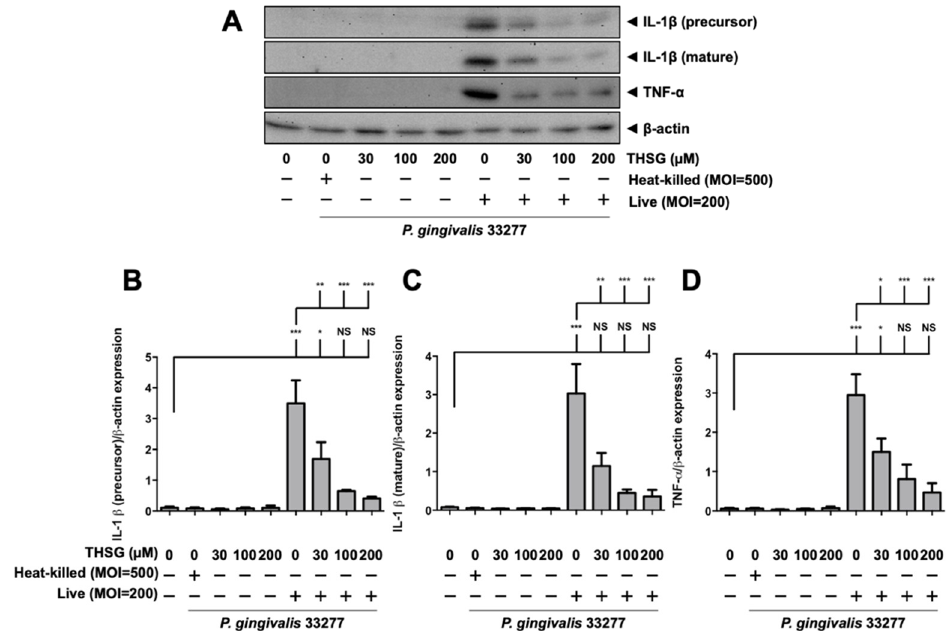
Figure 2. THSG reduces the expression of proinflammatory cytokines in P. gingivalis -infected bEnd.3 cells. ( A ) Cells were pretreated with THSG (0, 30, 100, and 200 µ M) for 2 h before being challenged with heat-inactivated (MOI 500) or live (MOI 200) P. gingivalis for 90 min. The expression of IL-1 β (precursor), IL-1 β (mature), and TNF- α proteins 24 h after infection were examined using Western blot analysis. The quantitative results of IL-1 β (precursor; ( B )), IL-1 β (mature; ( C )), and TNF- α ( D ) expression were calculated from mean density per area and represented as bar graphs. Data are expressed as mean values ± SEM (n = 4). Significant difference of the control or THSG 0 μ M group are presented as *, p < 0.05; **, p < 0.01; ***, and p < 0.001. NS: not significant.